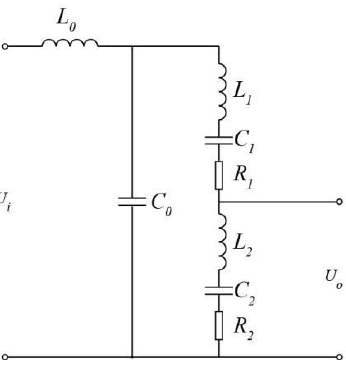
Figure 7. Equivalent circuit of the resistive–capacitive voltage divider during measurement of high-frequency voltage.